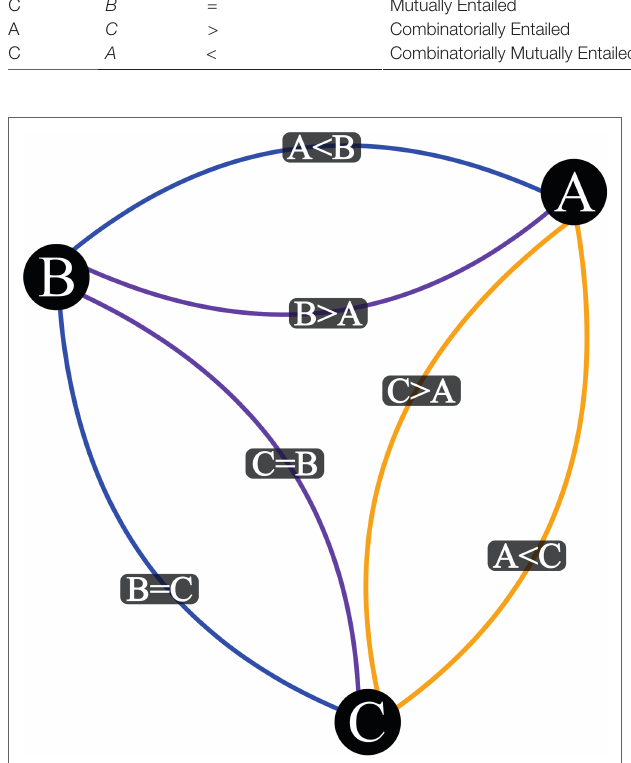
FIGURE 2 | Visualization Output for three Stimulus Mixed Relation Network with a Base Relational Set of A > B and B = C . Vertex represent stimuli, blue edges are input relations, purple edges are mutually derived relations, and orange edges are combinatorially derived